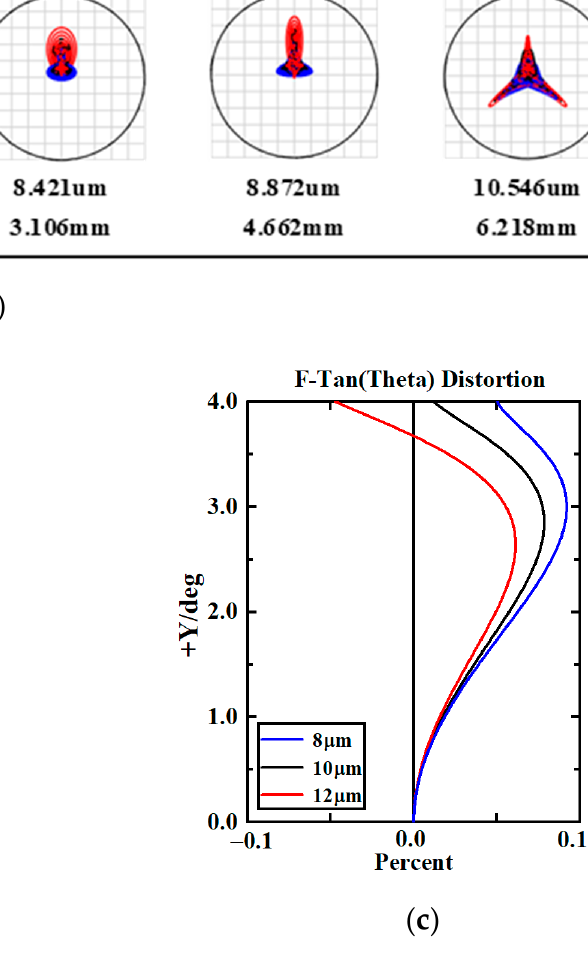
Figure 5. ( a ) Spot diagram of the fore-infrared system. ( b ) field curvature of the different wavelengths. ( c ) distortion of the different wavelengths.